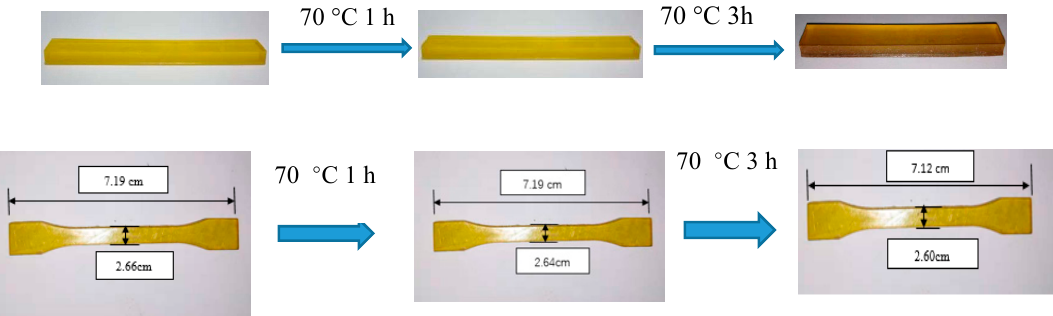
Figure 5. Morphological changes in the resin after different times at 70 °C.